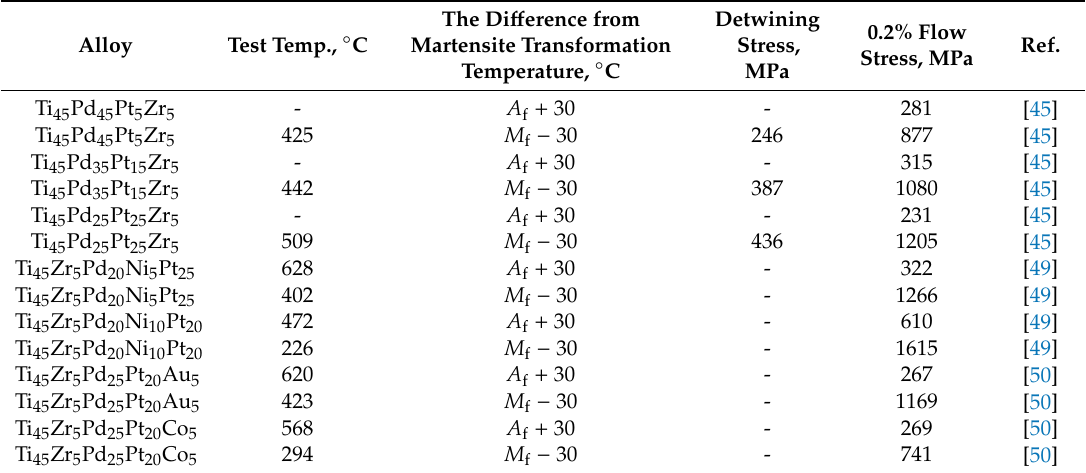
Table 7. Strength of the martensite and austenite phases of the multi-element alloys. Alloy Test Temp., ◦ C